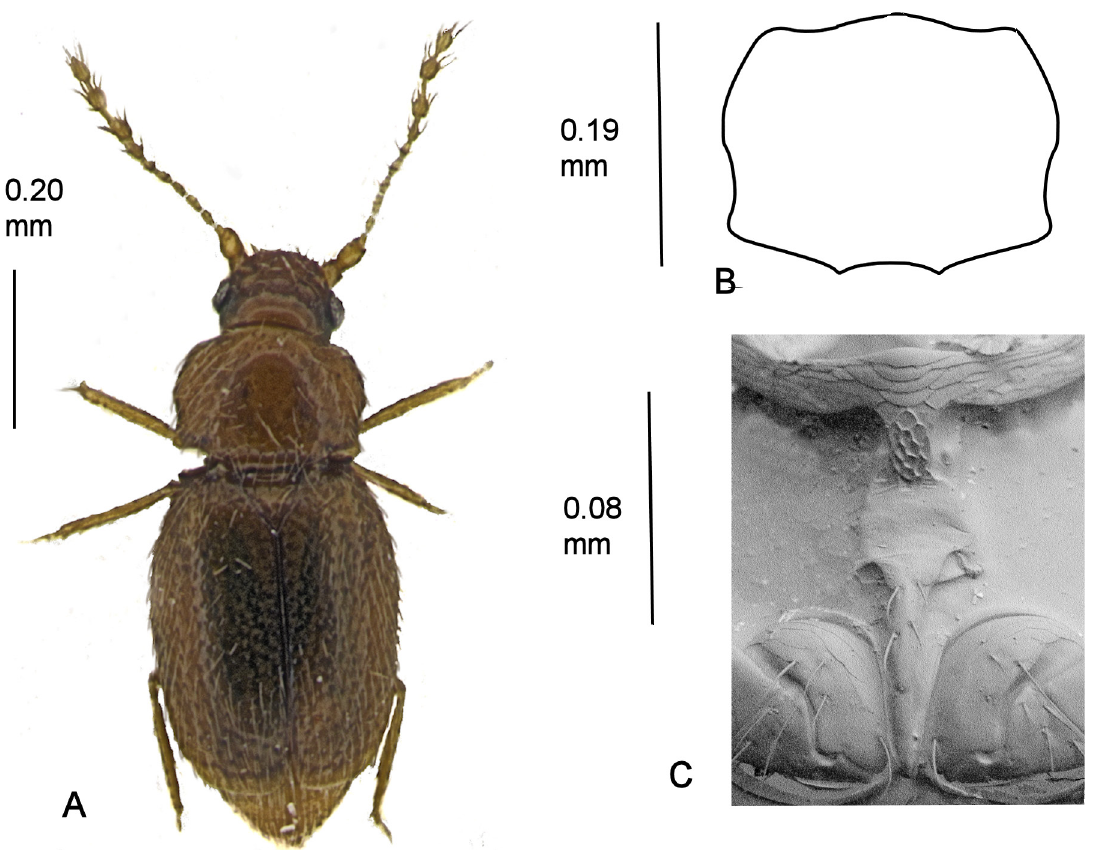
Fig. 47 . Cissidium amboroense Darby, 2015. A . Habitus. B . Pronotum. C . Mesoventrite showing median process of collar, mid-keel and keel,